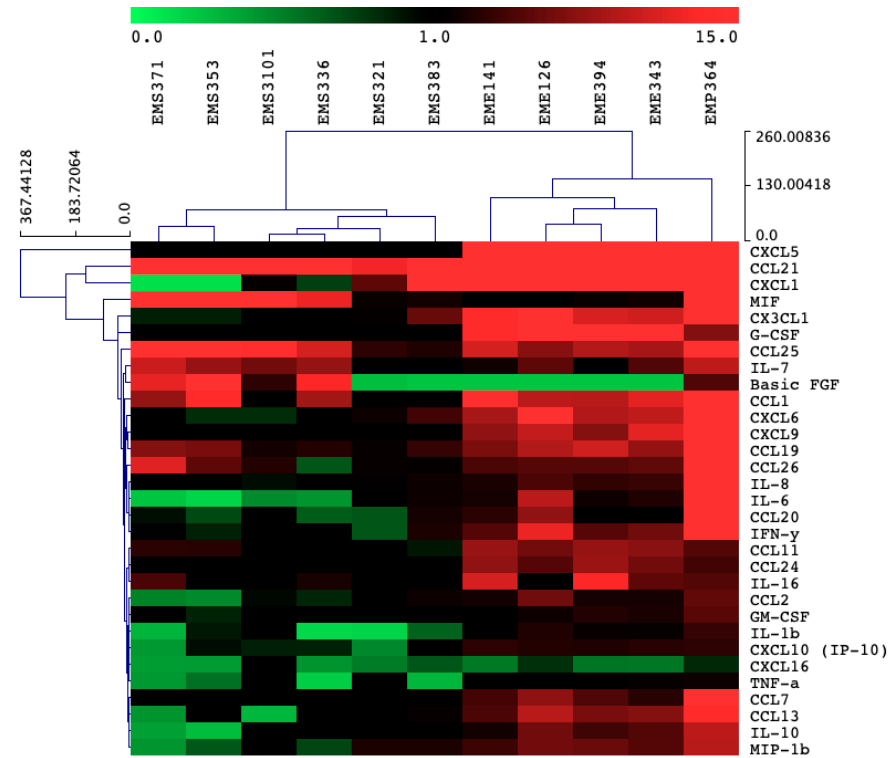
Figure 4. Similar patterns of cytokine, chemokine and growth factor production can be observed depending on the genera. Heatmap showing ratios (treatment / control, values not shown) of secreted proteins after 6 h incubation with bacterial strains. Strains are identified as follows: EMS , Streptococcus